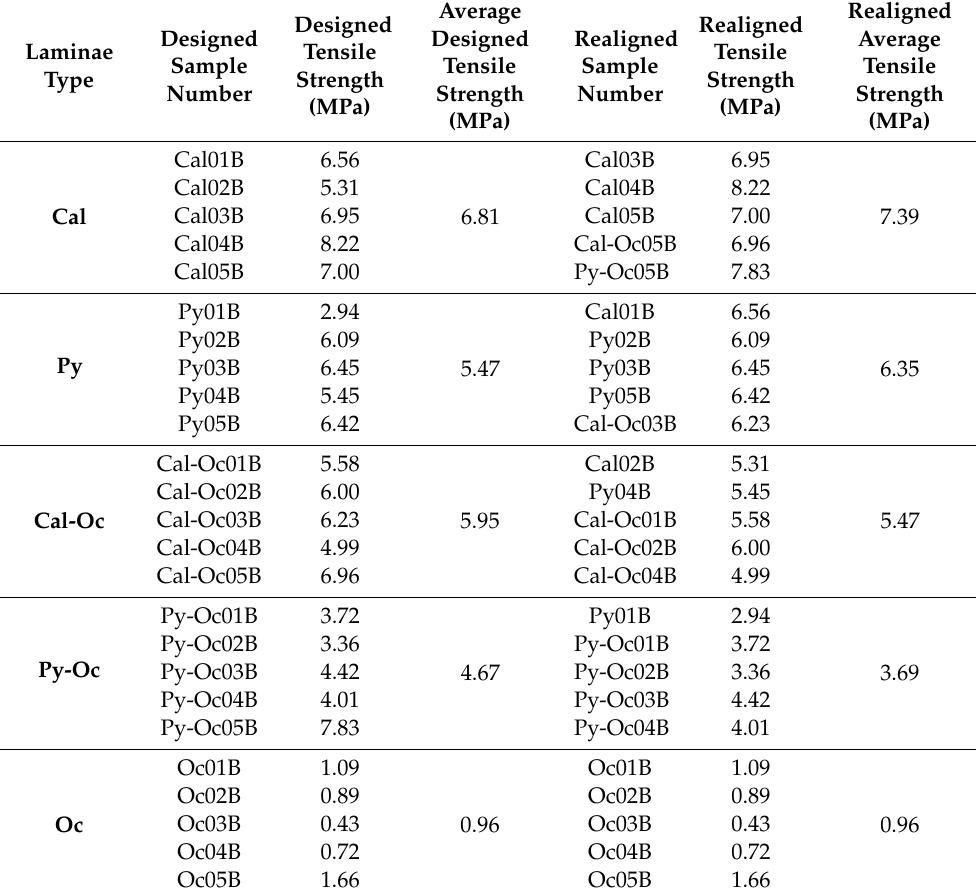
Table 1. Tensile strength of the Longmaxi Shale with various tested laminae in the center of